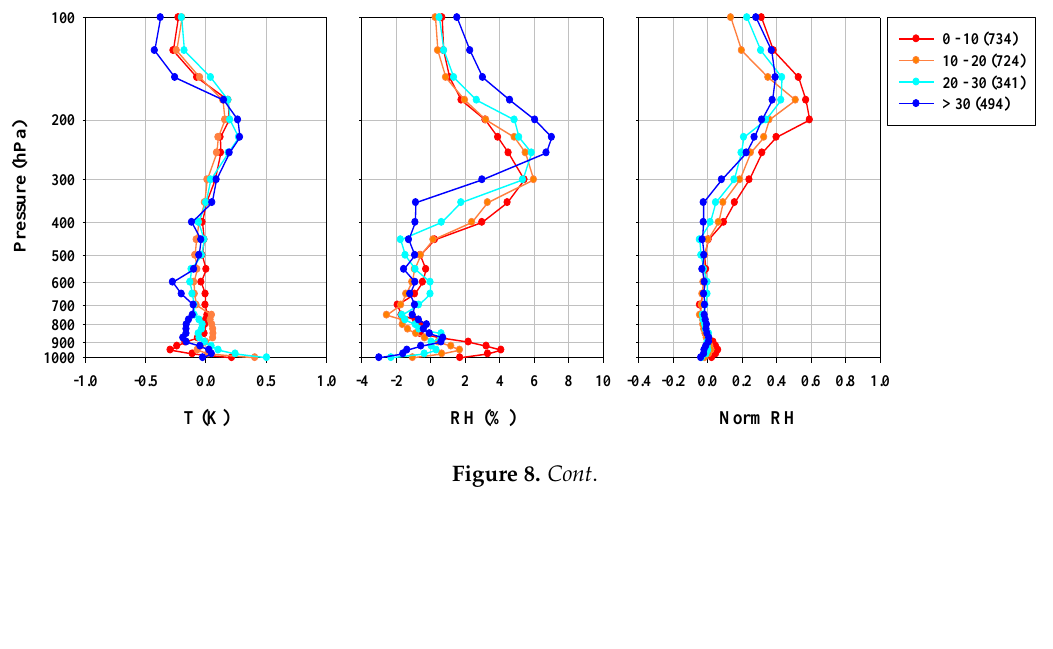
Figure 8. Cont. Figure 8. Cont.